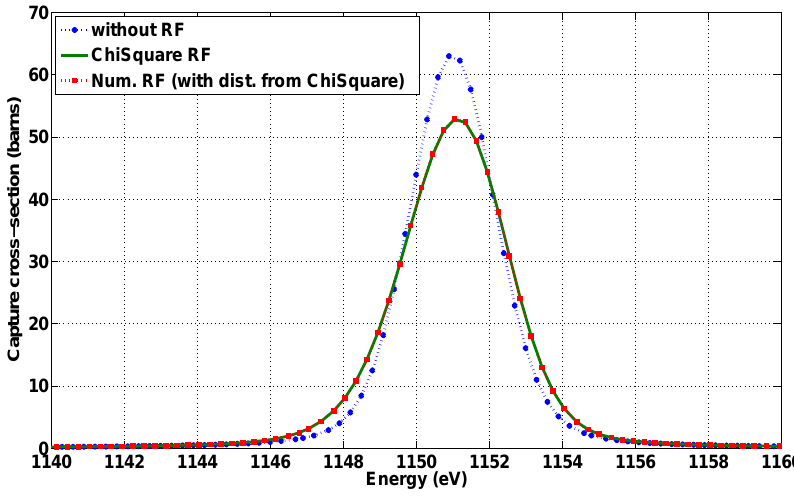
Figure 3. Capture cross-sections from CONRAD without resolution broadening, with the χ 2 and with the nu- merical resolution